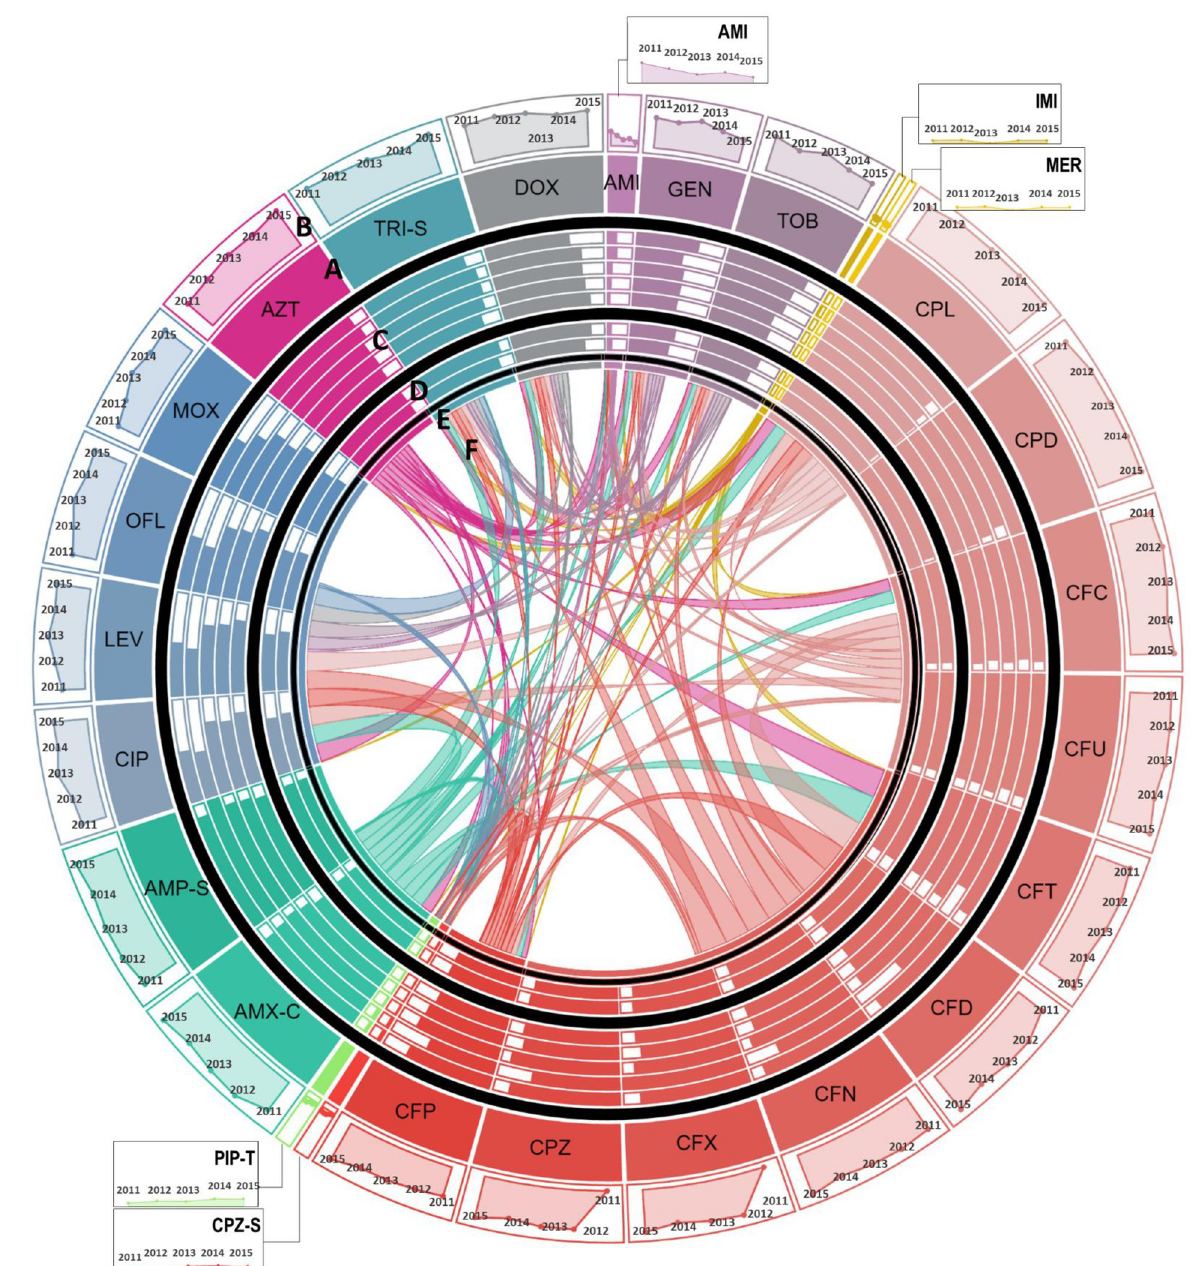
Fig 2. Antimicrobial resistance in Escherichia coli ( E . coli ). A: Each section of the diagram represents the resistance observed in E . coli against the antibiotic. Size of each section is proportional to the proportion of E . coli resistant to the antibiotic over the study period. Antibiotics of the same class are shown in similar colors. B: Line graphs show temporal trends of proportion of resistant E . coli in a clockwise direction from 2011 to 2015. C: Bar charts show the comparison of susceptibility to resistant strains in patients of different age groups. Moving from out to inward, bars represent proportion of resistant E . coli reported in children < 5 years of age, young adults between 6 to 18 years, middle aged 19 to 45 years old, 45 to 65 years old patients, and elderly over 65 years of age, respectively. D: Gender-wise comparison to susceptibility to resistant E . coli is shown in form bars. Outer circle and inner circle shows proportion of resistant E . coli isolated from women vs. men, respectively. E: For co-resistance analysis, antibiotics belonging to the same class with same susceptibility profile for all isolates of E . coli were merged into a single variable. F: Proportion of E . coli isolates resistant to one antimicrobial resistant to another antimicrobial are shown in the connections. The area covered by the connection on E is proportional to the level of co-resistance observed. Co-resistance proportions were scaled down to 1/15 th of the actual overlap for visualization. Abbreviations: AMI: Amikacin, GEN: Gentamicin, TOB: Tobramycin, IMI: Imipenem, MER: Meropenem, CPL: Cephalexin, CPD: Cephradine, CFC: Cefaclor, CFU: Cefuroxime, CFT: Cefotaxime, CFD: Ceftazidime, CFN: Ceftriaxone, CFX: Cefixime, CPZ: Cefoperazone,